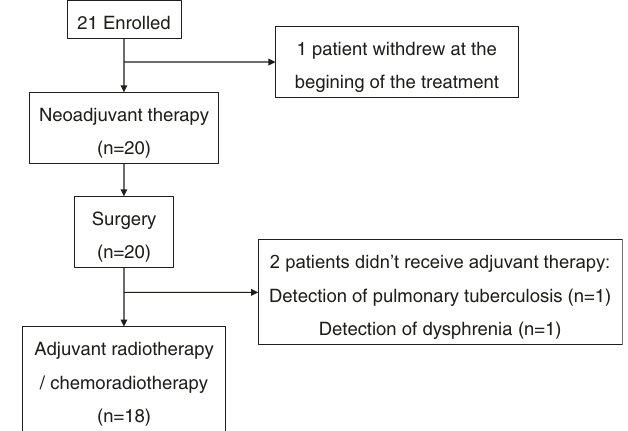
Fig.1|Trial fl owchart. 21patientswereenrolledinthistrial;20 patientsreceived neoadjuvant therapy and surgery; among them, 18 patients received adjuvant